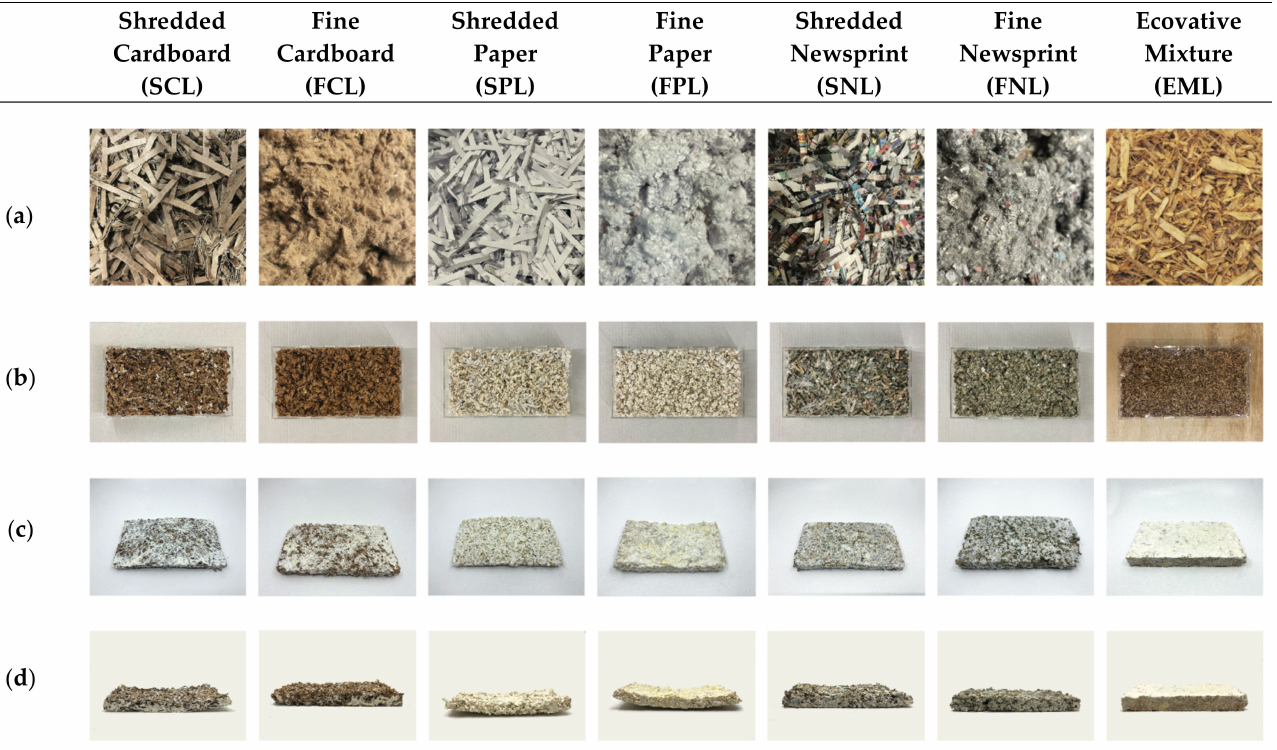
Figure 2. Growth Process of Low-Frequency Samples and Resulting Materials: ( a ) Prepared Substrates (80 mm × 80 mm square); ( b ) Mycelium Mixtures in Formworks (250 mm × 125 mm × 38 mm); ( c ) Composite Materials After Drying (250 mm × 125 mm × 38 mm); ( d ) Composite Materials After Drying—Side